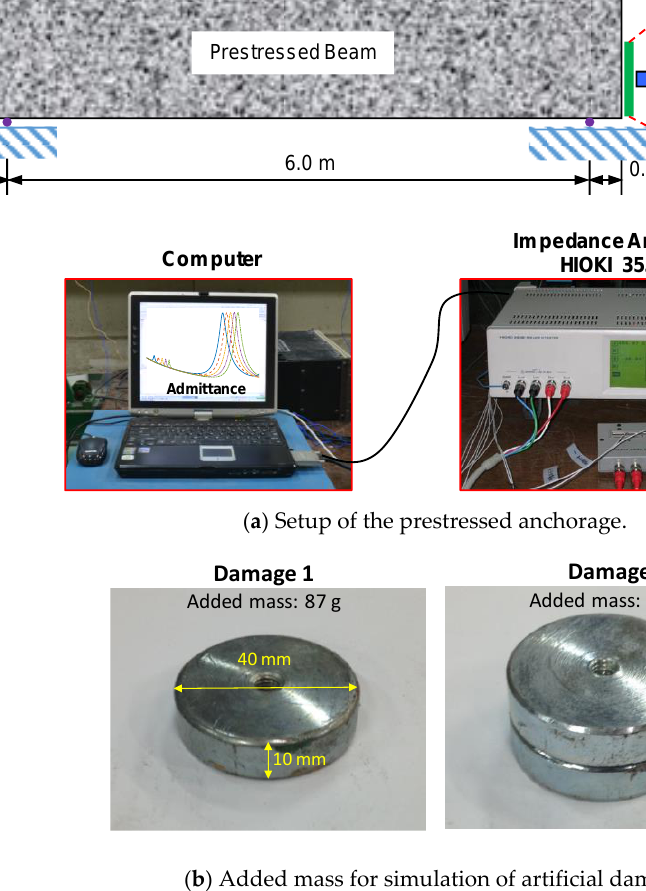
Figure 7. Experimental setup.